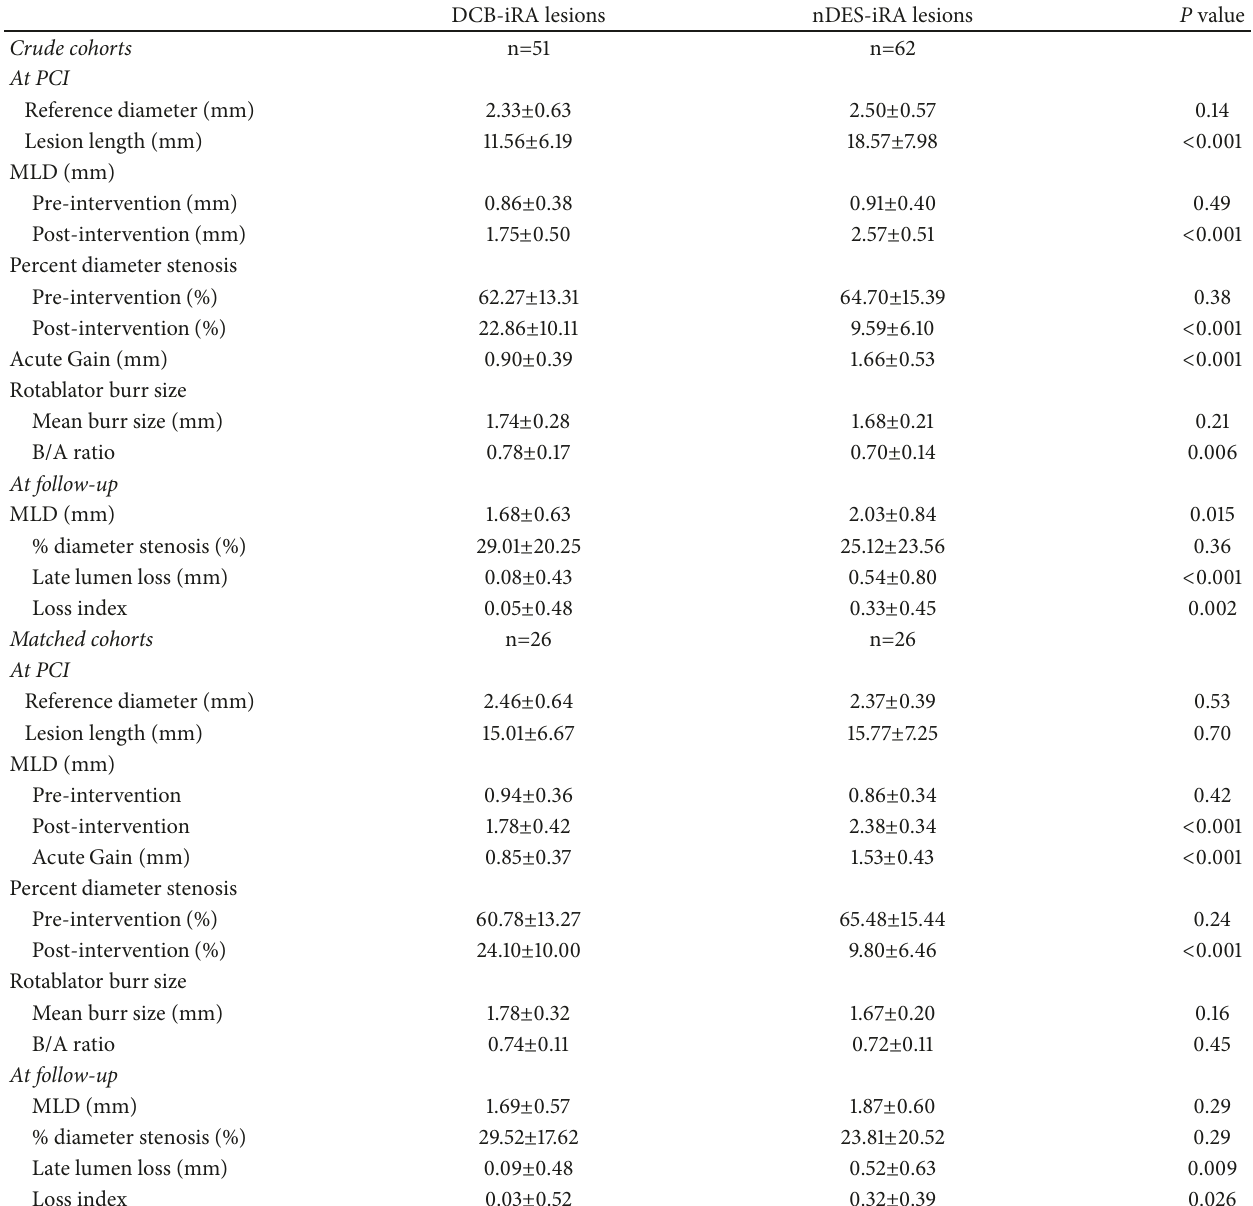
Table 5: Pre- and postprocedural quantitative angiographic characteristics in the crude and matched